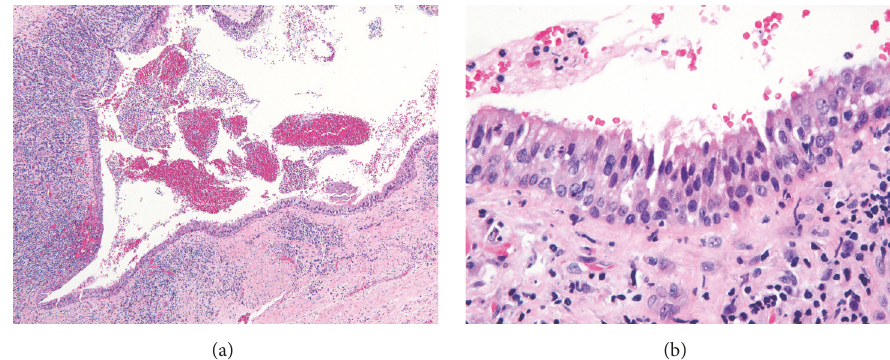
Figure 2: Histological aspect of radicular cyst: (a) cystic cavity containing hemorrhagic exudate and neutrophils lined exclusively by ciliated pseudostratifiedcolumnarepithelium.Thewallofthecystconsistsoffibrousconnectivetissuewithanintensechronicinflammatoryinfiltrate. (HES, × 6.4). (b) High magnification showing the ciliated pseudostratified columnar epithelium and inflammatory infiltrate represented by lymphocytes, plasma cells, and some neutrophils (HES, ×